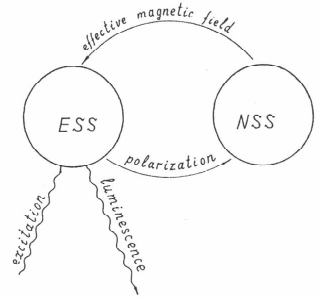
Figure 6. Feedback coupling of the electron spin system (ESS) and the nuclear spin system (NSS) in a semiconductor. Optically oriented electrons polarize the nuclei (arrow polarization ) Because of the polarization, an effective magnetic field arises, which, in its turn, affects the electron orientation and hence the luminescence polarization. (Reprinted from Reference [21], © (1984), with permission from Elsevier).